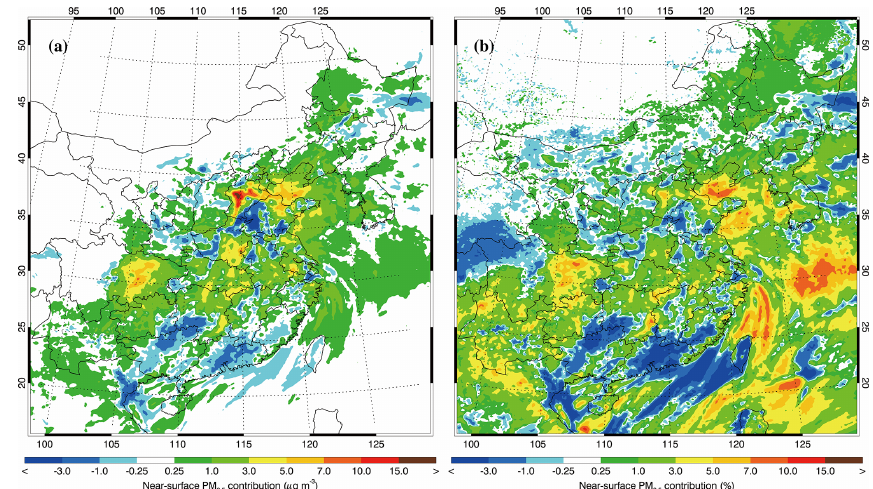
Figure 6. Average near-surface (a) absolute and (b) relative PM 2 . 5 contribution caused by the ALW-ARF from 5 December 2015 to 4 Jan- uary